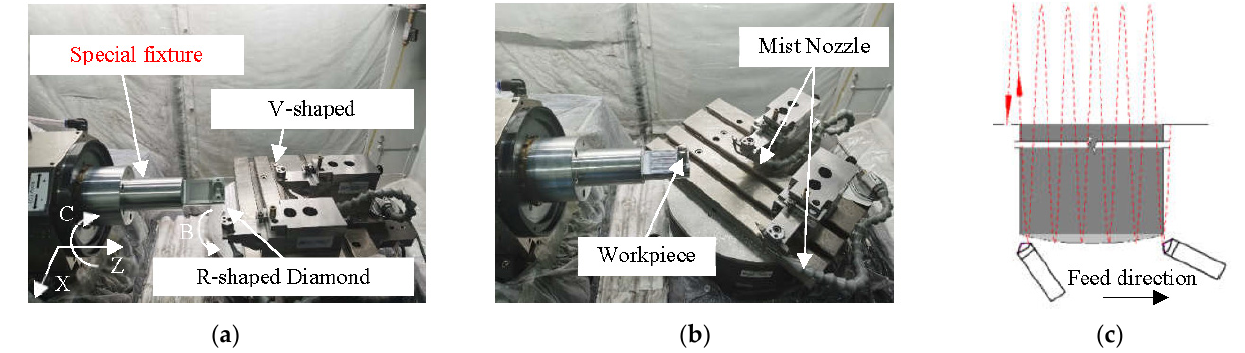
Figure 5. Workpiece and tool clamping methods. ( a ) When machining convex spherical surfaces. ( b ) When machining convex spherical gratings. ( c ) Feed direction of tool.